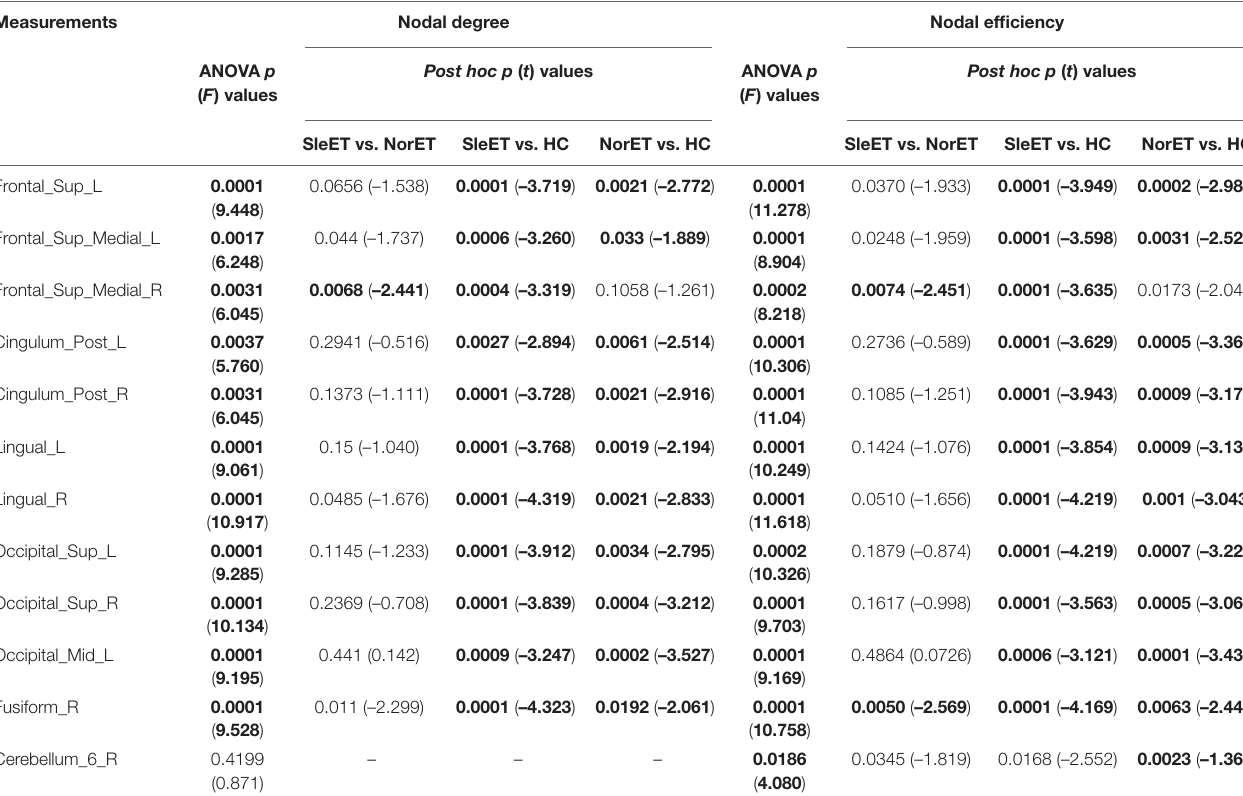
TABLE 3 | Nodal brain topological metrics showing differences between the SleET and NorET patients and HCs. Measurements Nodal